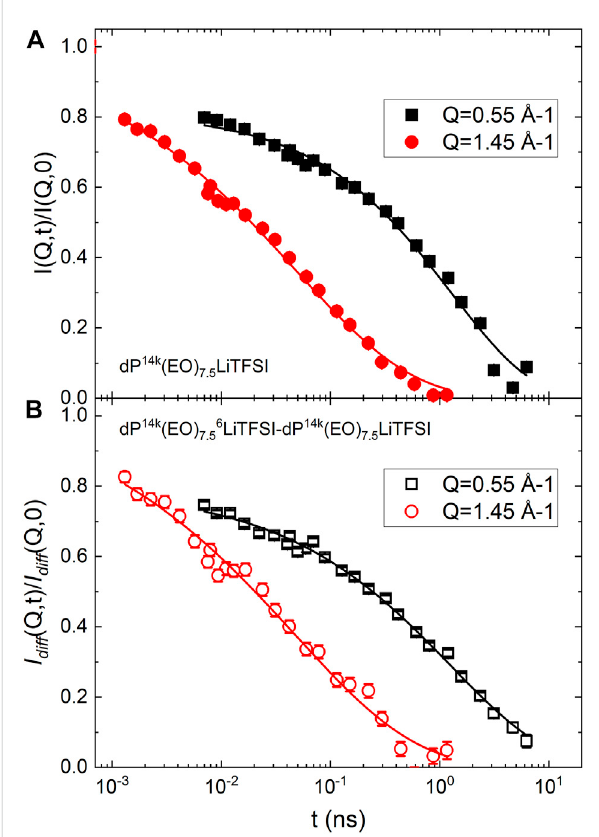
FIGURE 3 (A) The normalized ISF of sample 1b measured on WASP at the ERO and IRO peaks at a temperature of 373 K. (B) The normalized ISF I diff (Q,0)/ I diff (Q,0) measured on WASP using the data from sample 1b andsample2attheEROandIROpeaksatatemperatureof373 K. In both (A,B) the continuous lines are fi t using Eq. 15. Error bars represent standard